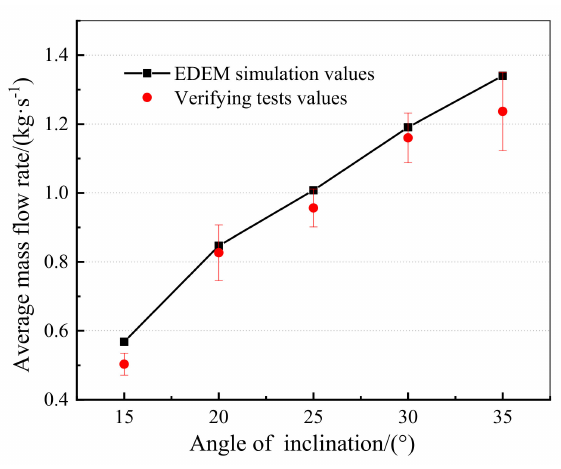
Figure 9. The physics and simulation test results of the flow rate were carried out using the fallen jujube fruit (FJF) guide